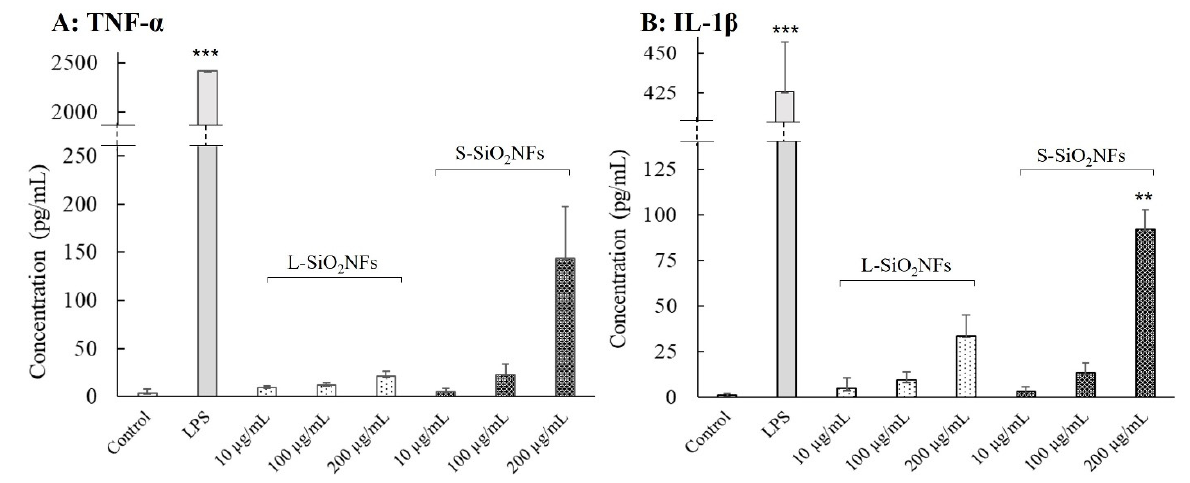
Figure 4. The effect of SiO 2 NF lengths on the cytokine expression. TNF- α (plot A ) and IL-1 β (plot B ) productions were detected with the ELISA assay. THP-1 cells were seeded at 3 × 10 4 /well and differentiated with PMA. THP-1-derived macrophage-like cells were treated for 24 h with different SiO 2 NFs concentrations, and the supernatants were analyzed by ELISA according to the manufacturer’s instructions. The assay was repeated 4 times, each time in duplicate. Statistical analysis was performed by one-way analysis of variance, *** p < 0.001 and ** p = 0.006 ( n = 8).